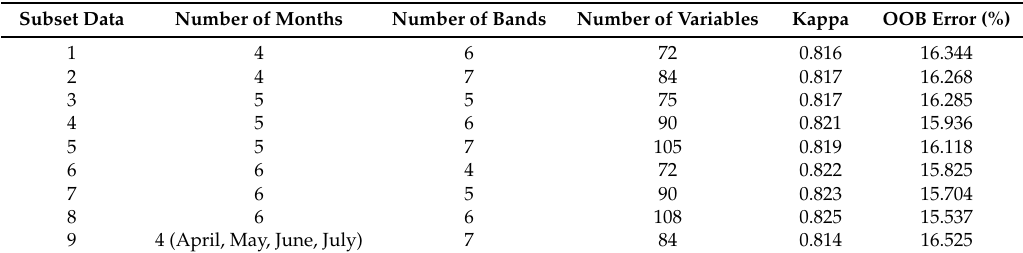
Table 1. Results of experimental runs. OOB: Out of Bag.